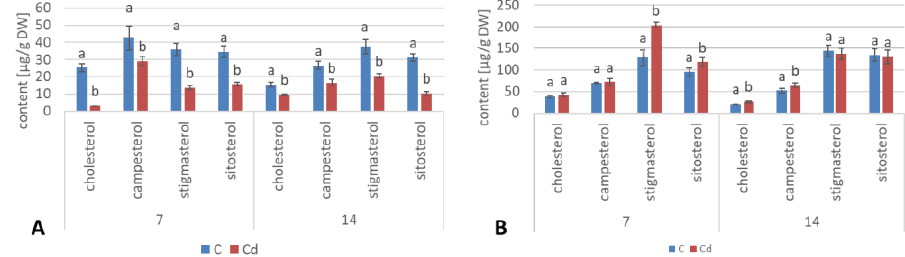
Figure 21. The content of sterol esters ( A )and sterol glycosides ( B ) in C. officinalis shoots. Bars which do not share a common letter are significantly different ( p < 0.05).